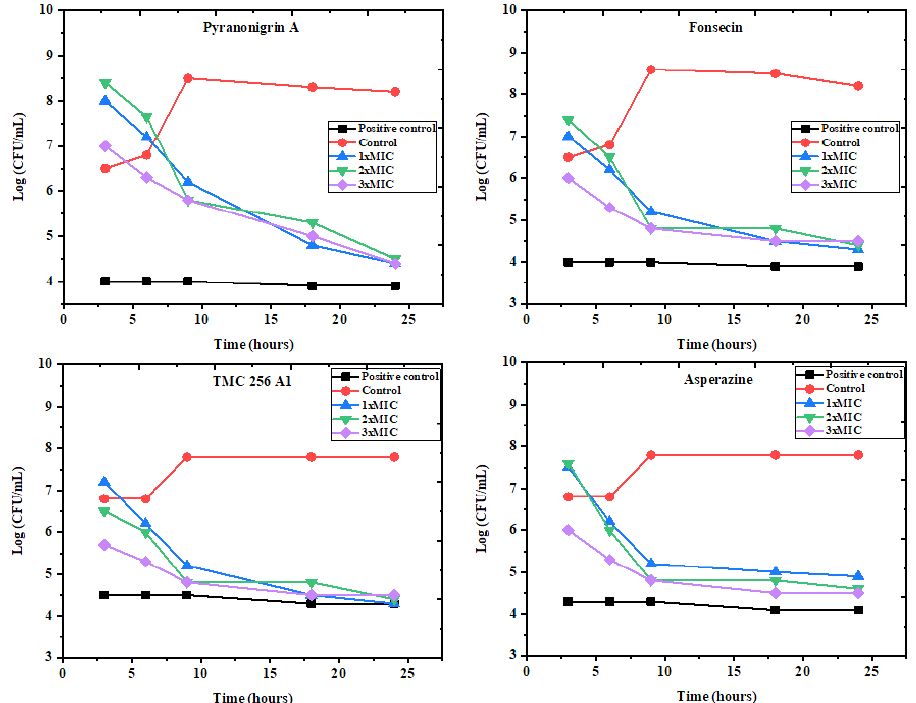
Figure 7. The time – kill kinetics of pure compounds ( 1 – 4 ) obtained from the active fraction of A. tubingensis (NA103) against E. coli. Red control indicates cells without treatment, while positive con- trol indicates treated cells with 50 mg/mL of tetracycline.